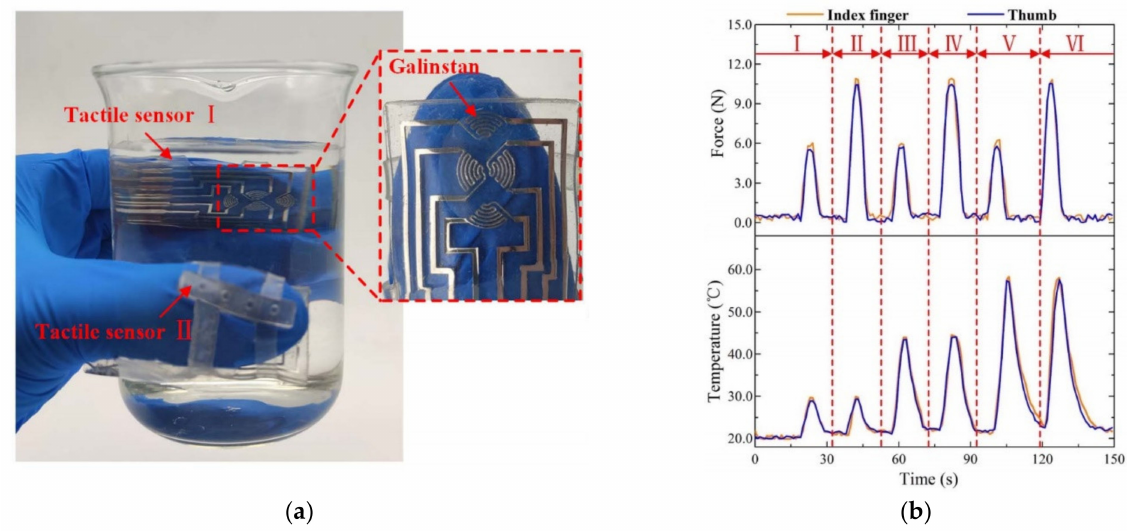
Figure 18. ( a ) Tactile sensors worn on the index finger and thumb of the human hand that were used to grasp a beaker of water; ( b ) Results of sensing force and temperature. Reprinted with permission from Ref. [60]. Copyright 2021